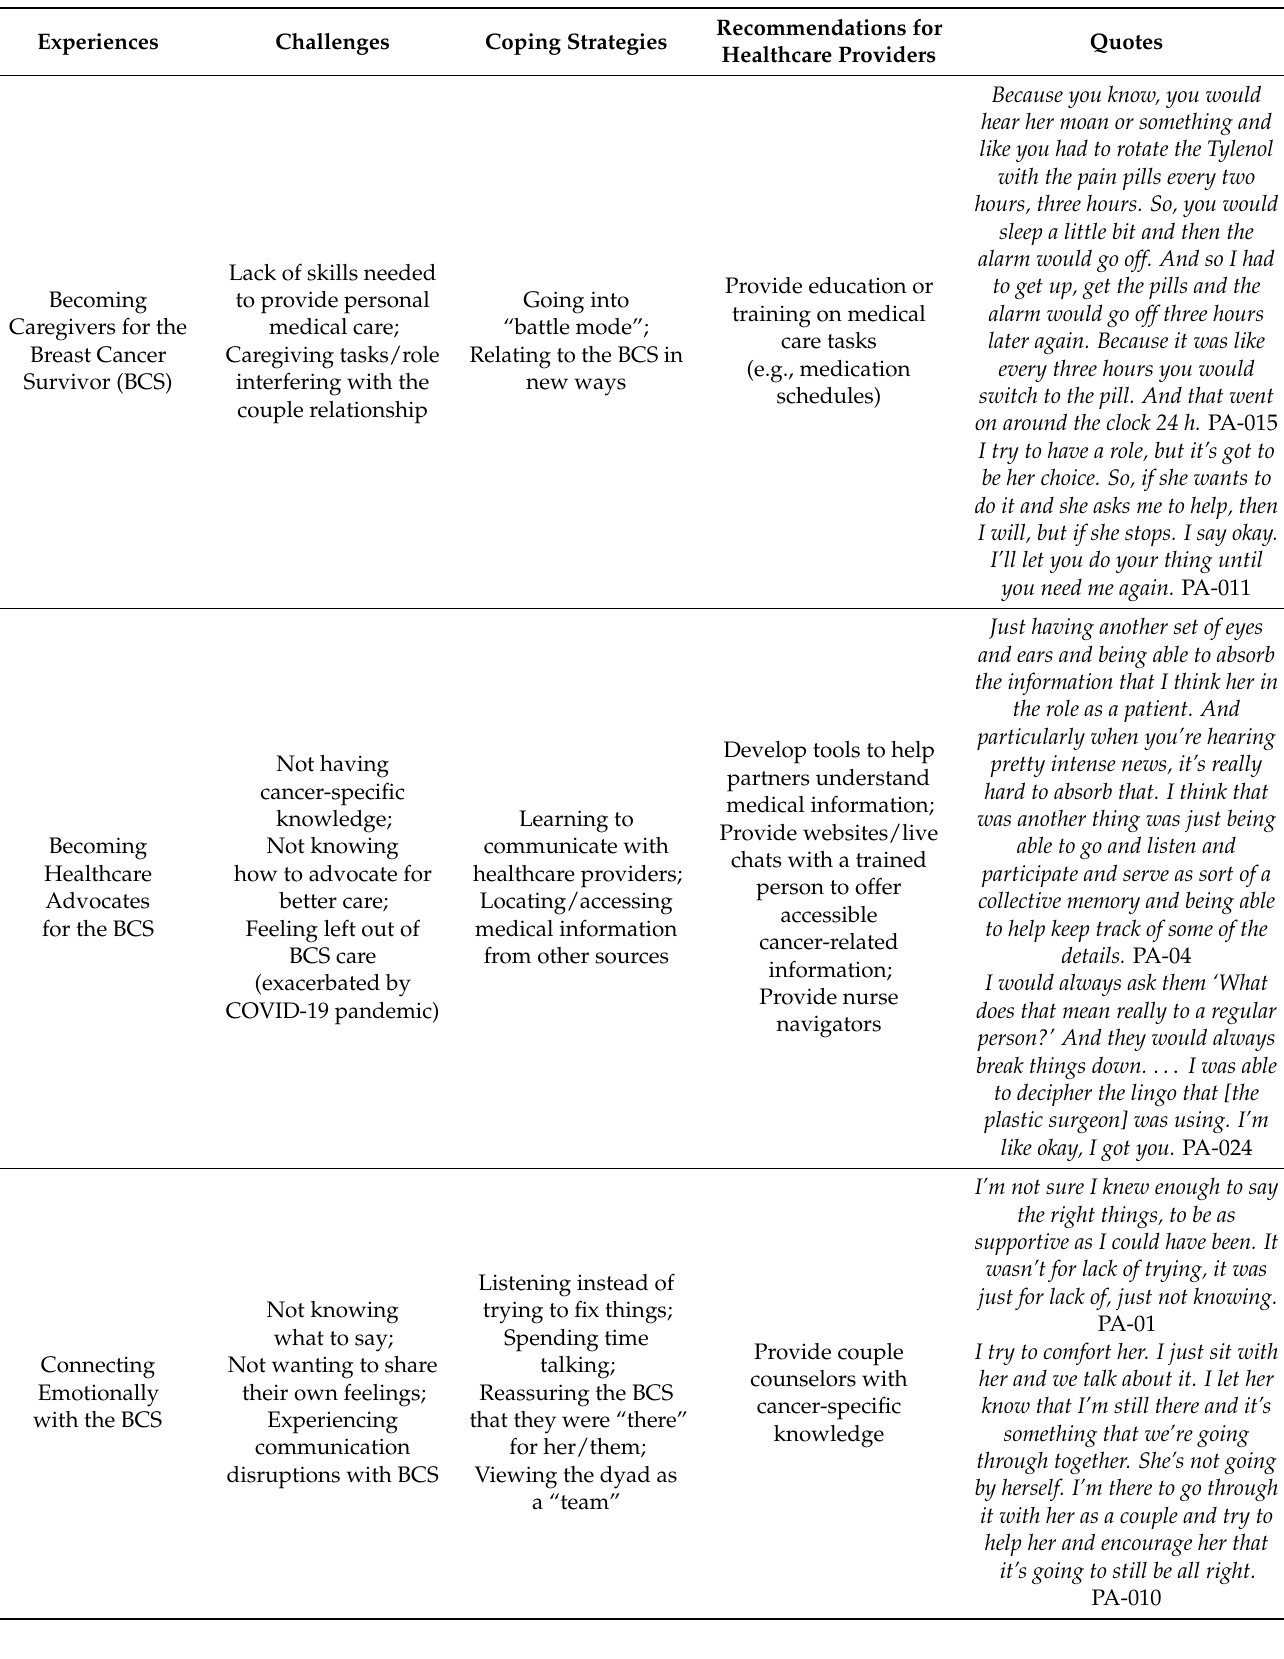
Table 2. Overview of partners’ self-reported experiences, challenges, and coping strategies. Recom- mendations for providers are included with exemplar